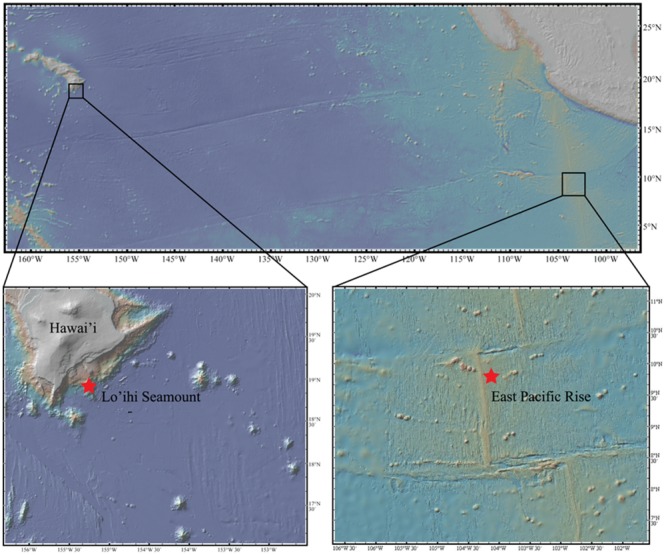
Map of study sites.